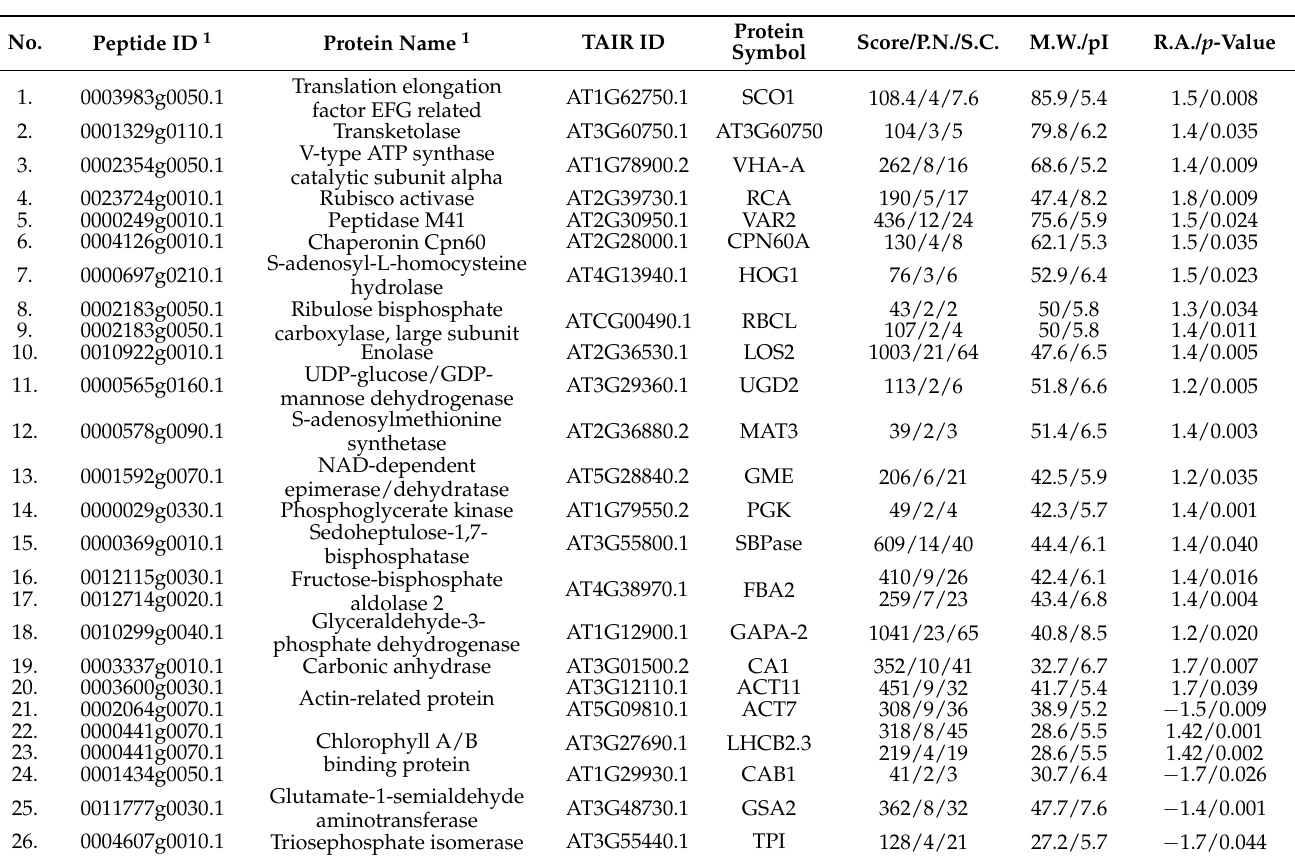
Table 2. Proteoforms differentially carbonylated between timentin-treated and control tobacco in vitro shoot